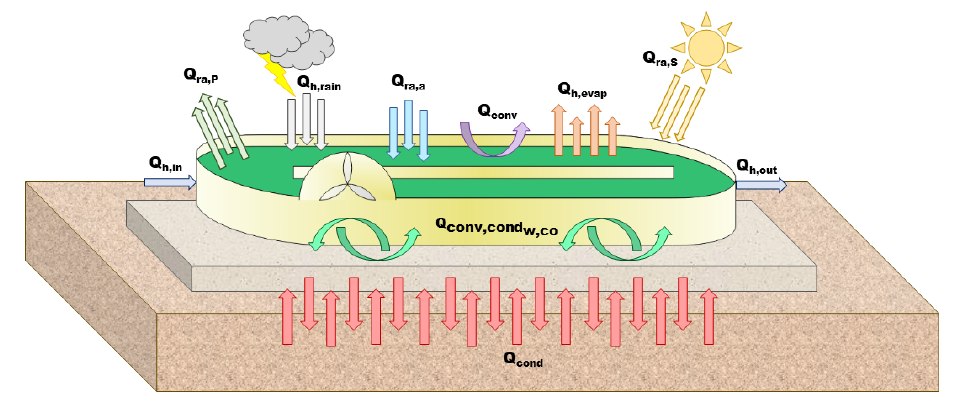
Figure 8. Scheme of the standard HRABP lying on the ground, with the heat fluxes considered in the radiative transfer model.